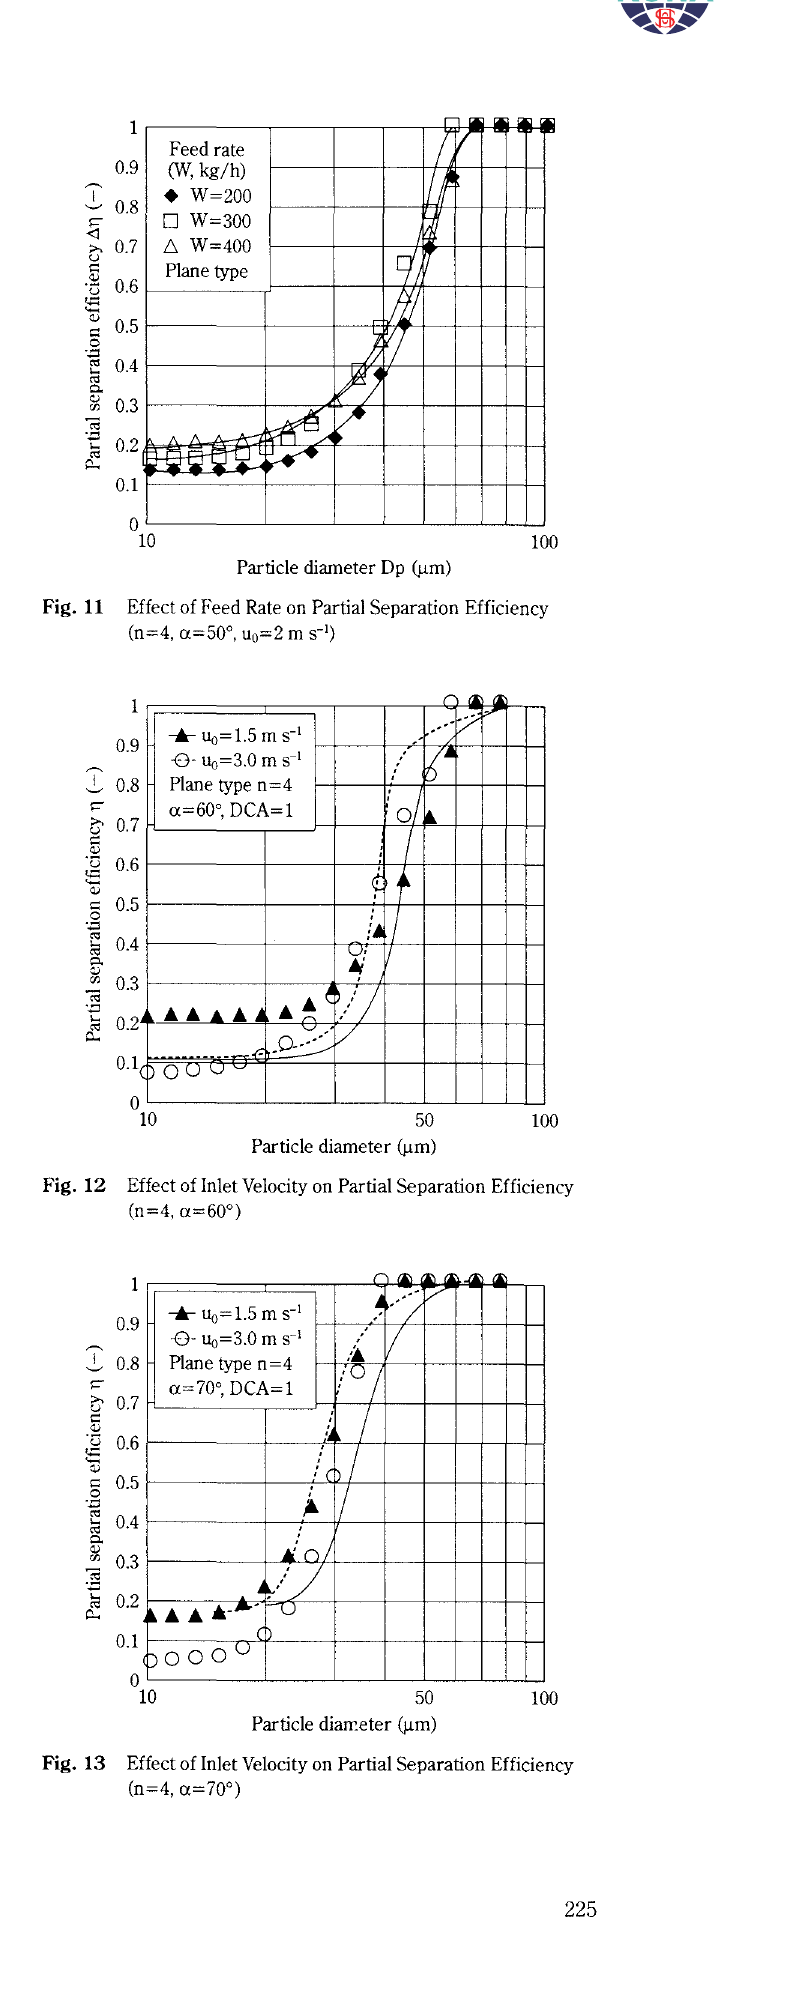
Fig. 11 Effect of Feed Rate on Partial Separation Efficiency (n=4, a=50°, u 0 =2 m s· 1)